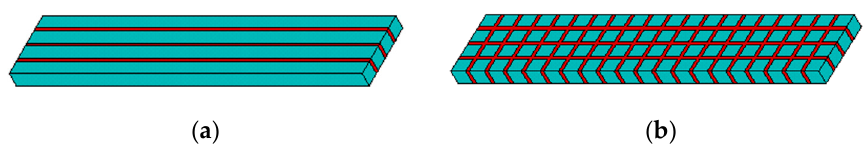
Figure 3. Structures of the 2 ‐ 2 and 1 ‐ 3 type piezoelectric composite. ( a ) 2 ‐ 2 type. ( b ) 1 ‐ 3 type.